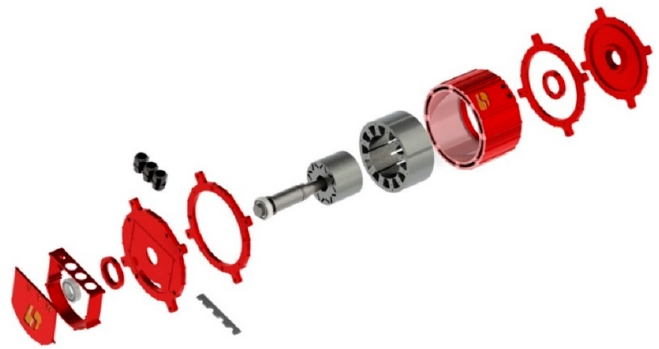
Figure 1. Exploded view of the PMSM to be controlled by the proposed controller.